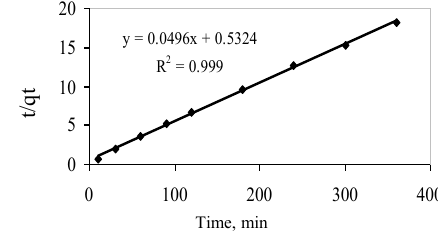
Figure 6. Plots of pseudo-second-order equation for U(VI) adsorption ([U] = 20 mg/L, pH=6.5, T=303K).